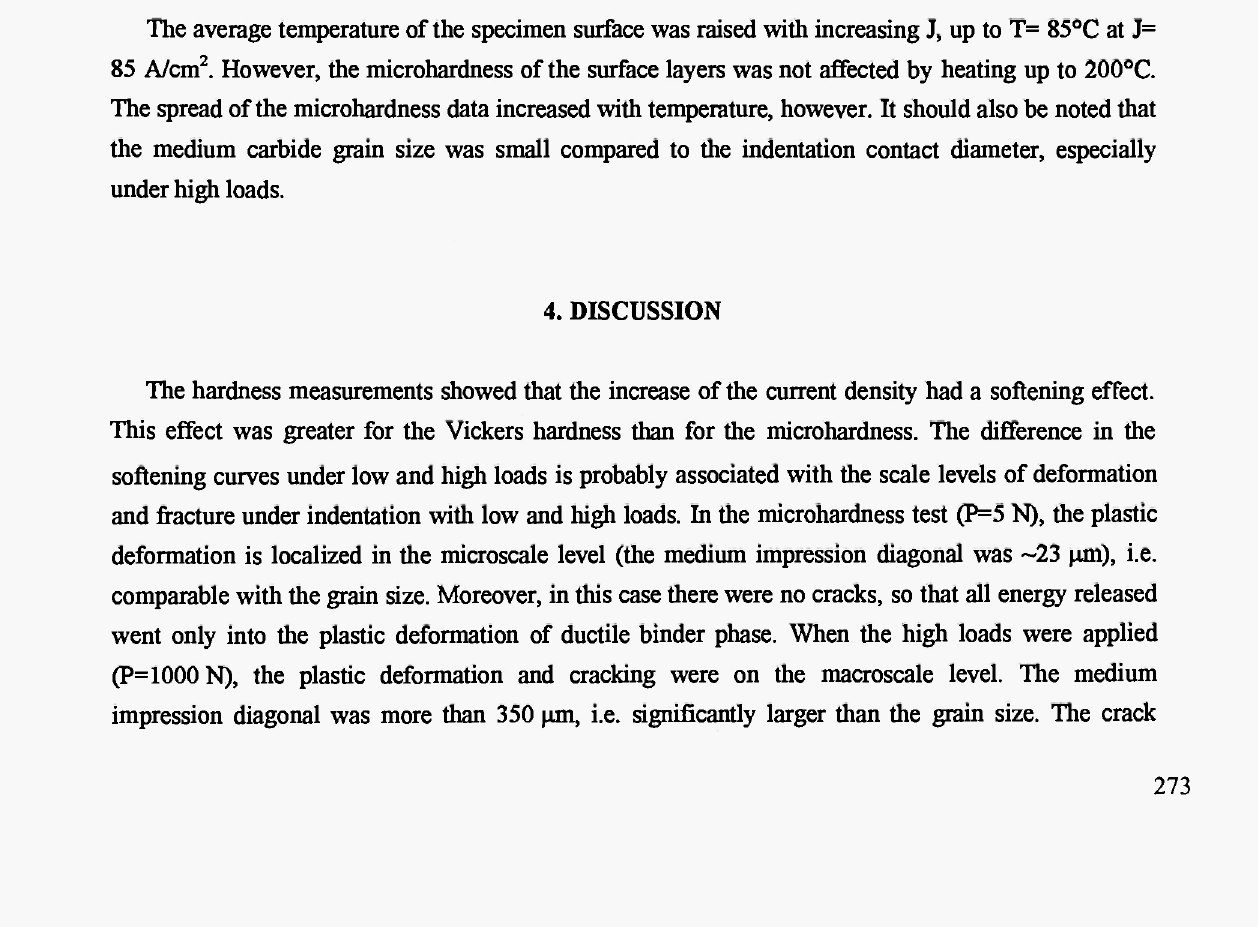
Fig. 6: Effect of the current injection on linear density of cracks and length of cracks around Rockwell